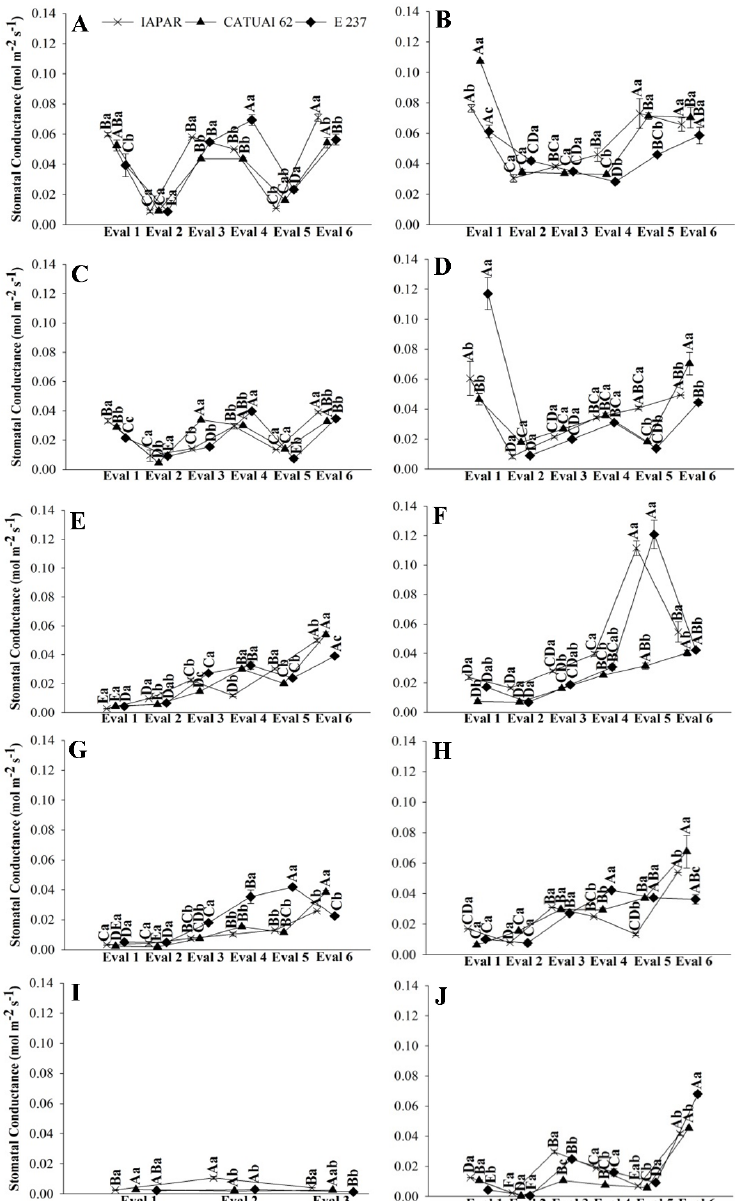
Figure 1. Stomatal conductance of coffee leaves under water stress (Eval 1) and after the return of irrigations (Eval 2 to 6), in 2019 and 2020, of three genotypes of arabica coffee (Iapar 59, Catuaí 62 and E237) subjected to five water regimes (FI 100 ( A , B ), FI 50 ( C , D ), WD 100 ( E , F ), WD 50 ( G , H ) and rainfed ( I , J )). Capital letters compare the water regimes for each cultivar and lowercase letters compare the cultivars of each water regime. Means followed by the same letter do not differ according to the Tukey test at 5% probability. FI 100 and 50 (full irrigation with 100% and 50% replacement of evapotranspiration); WD 100 and 50 (water deficit with the suspension of irrigation from June to September, with replacement of 100% and 50% of evapotranspiration, respectively); rainfed (without irrigation).